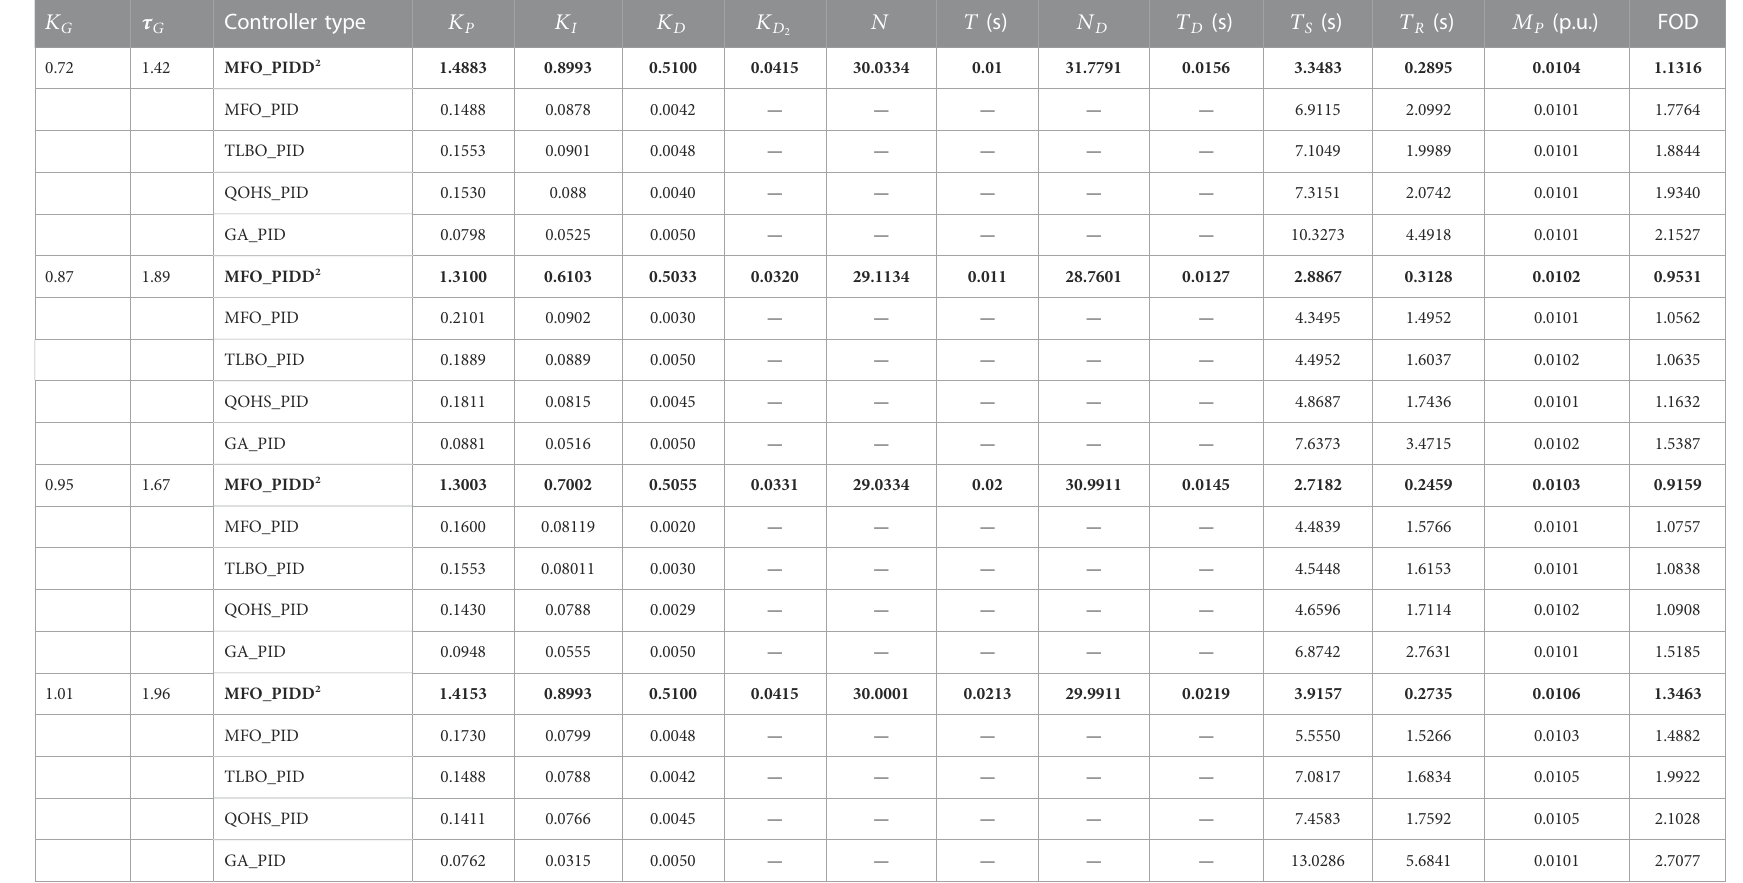
TABLE 4 SFL-based controller gains, Transient characteristics, and FOD values. K